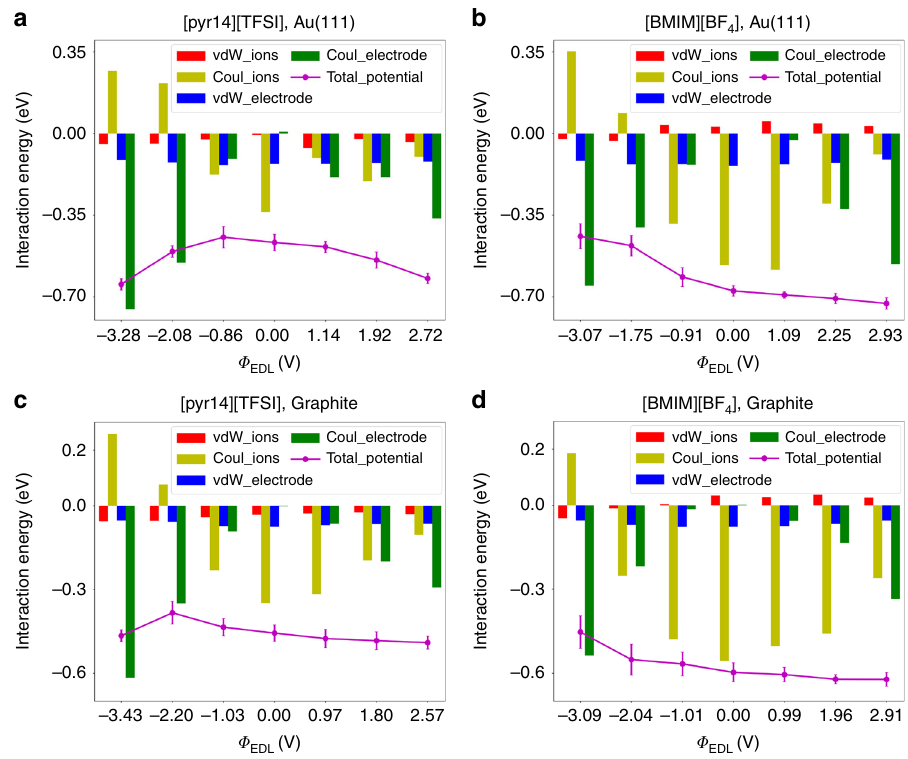
Fig. 5 Interaction energies at different electrode polarizations. The weight of different components of the total interaction energy of water molecule adsorbed at the electrode surface under different electrode polarizations ( Φ EDL ). a – d The fi gures for water adsorbed from 1-butyl-1-methylpyrrolidinium bis (tri fl uoromethylsulfonyl)imide ([pyr14][TFSI]) ( a ) and 1-butyl-3-methylimidazolium tetra fl uoroborate ([BMIM][BF 4 ]) ( b ) near gold electrode and from [pyr14][TFSI] ( c ) and [BMIM][BF 4 ] ( d ) near carbon electrode. Red, yellow, blue, and green bar charts represent water – ions van der Waals, water – ions coulombic, water – electrode van der Waals, and water – electrode coulombic interactions, respectively. The magenta dots connected by solid lines are the total value of “ local ” potential energy of water with its nearby species in the interfacial region, which results from the summation of previous four interactions. The error bars for magenta dots are due to the standard deviation of the results for three independent simulation cases. Source data are provided as a Source Data fi